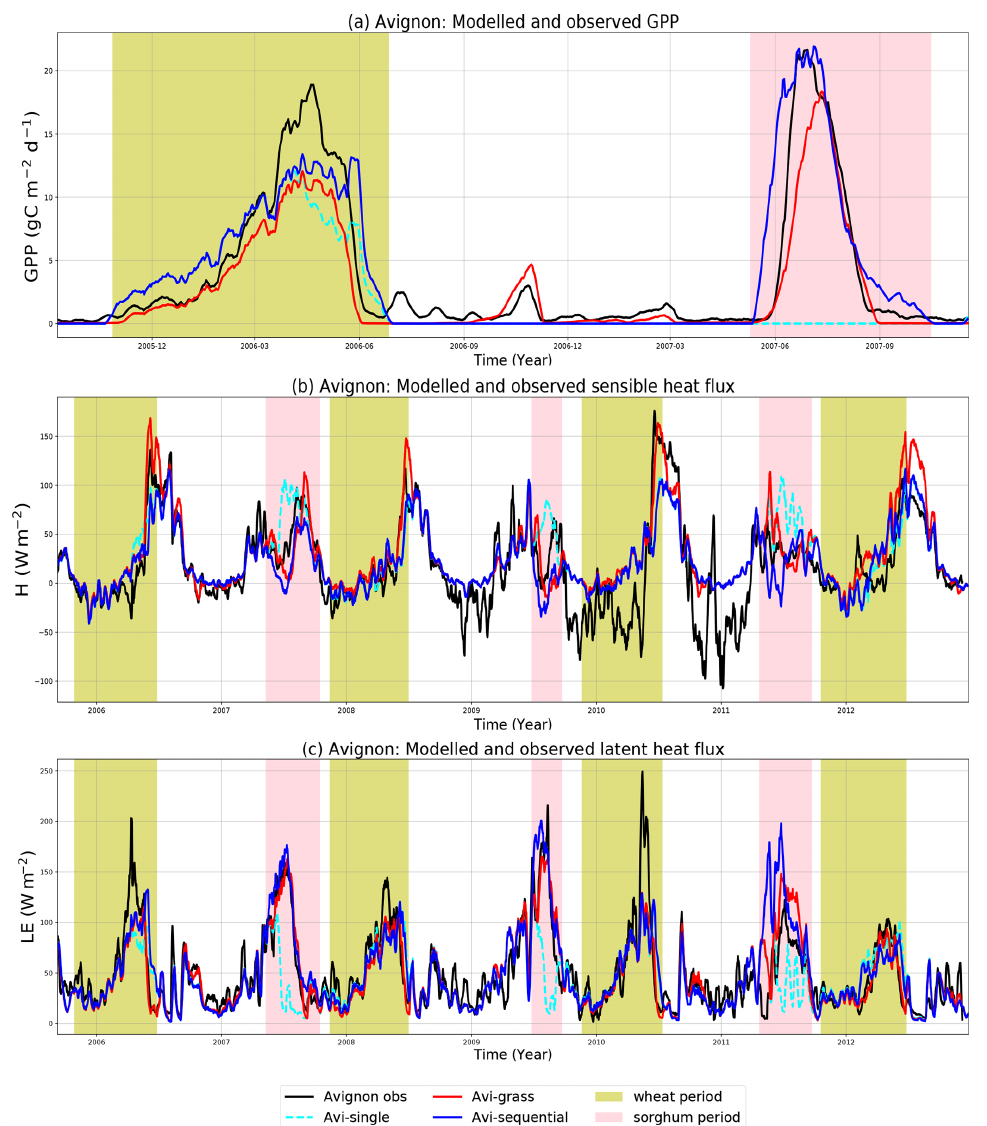
Figure 5. Time series of GPP (a) , H (b) and LE (c) for the Avignon site compared with observations (black lines). For H (b) and LE (c) , the whole period from 2005 to 2012 is shown, while GPP (a) shows the period 2005–2007 due to availability of observations. In the GPP plot, only one complete winter wheat (yellow) and one complete sorghum season (pink) are highlighted. The following model simulations are also shown: Avi-grass (red), Avi-sequential (blue) and a wheat-only Avi-single (cyan). In each plot, a 10d smoothing has been applied to the daily